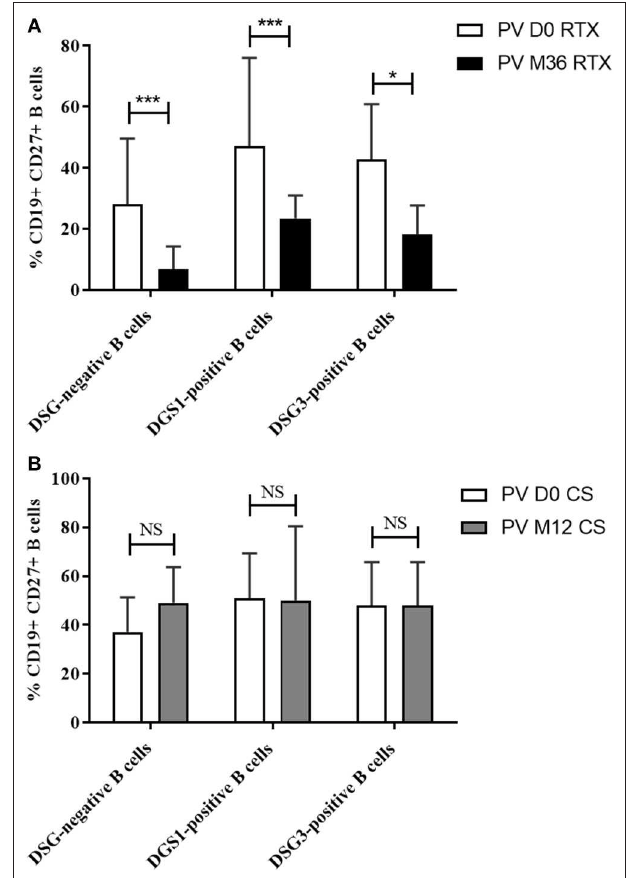
FIGURE 7 | (A) Percentage of memory B cells among non-desmoglein specific, desmoglein 1-specific (DSG1 + ), and desmogelin three-specific (DSG3 + ) B cells before (white columns) and after treatment with rituximab (black columns). (B) Percentage of memory B cells among non-desmoglein specific, desmoglein 1-specific (DSG1 + ), and desmogelin 3-specific (DSG3 + ) B cells before (white columns) and after treatment with corticosteroids (gray columns). Means ± standard deviations were compared using the Wilcoxon paired